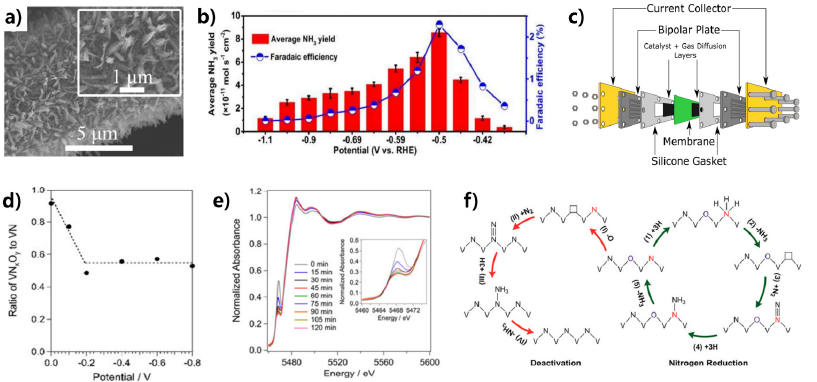
Figure 3. ( a ) SEM image of VN/CC. ( b ) NH 3 yield and FE at different potentials on VN/TM. ( c ) Schematic illustration of MEA. ( d ) VN x O y /VN ratio after 1 h of reaction at various potentials. ( e ) Operando XAS results of K-edge XANES of VN at − 0.2 V. ( f ) Proposed MvK mechanism of NRR and deactivation pathway on VN 0 . 7 O 0 . 45 . Reproduced with permission from the Royal Society of Chemistry [73] and the American Chemical Society [37,74,75].